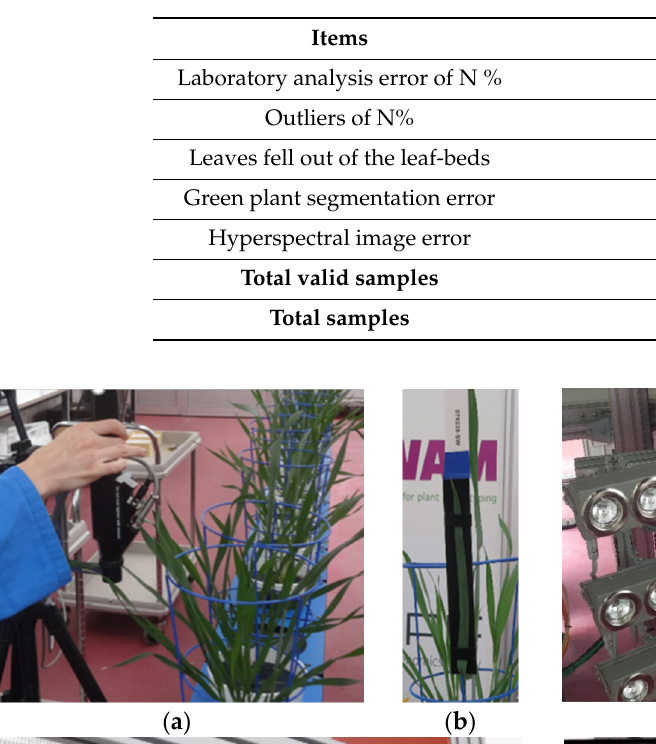
Table A2. Data errors and outliers.